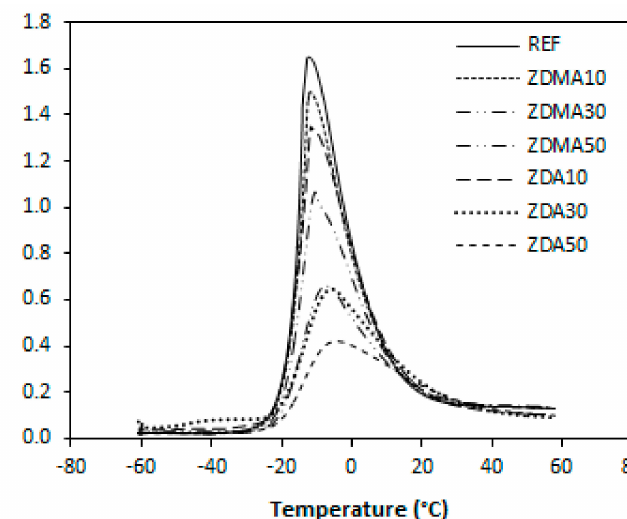
Figure 9. Variations of tan δ of reference composite cured only with peroxide and composites cured with different content of